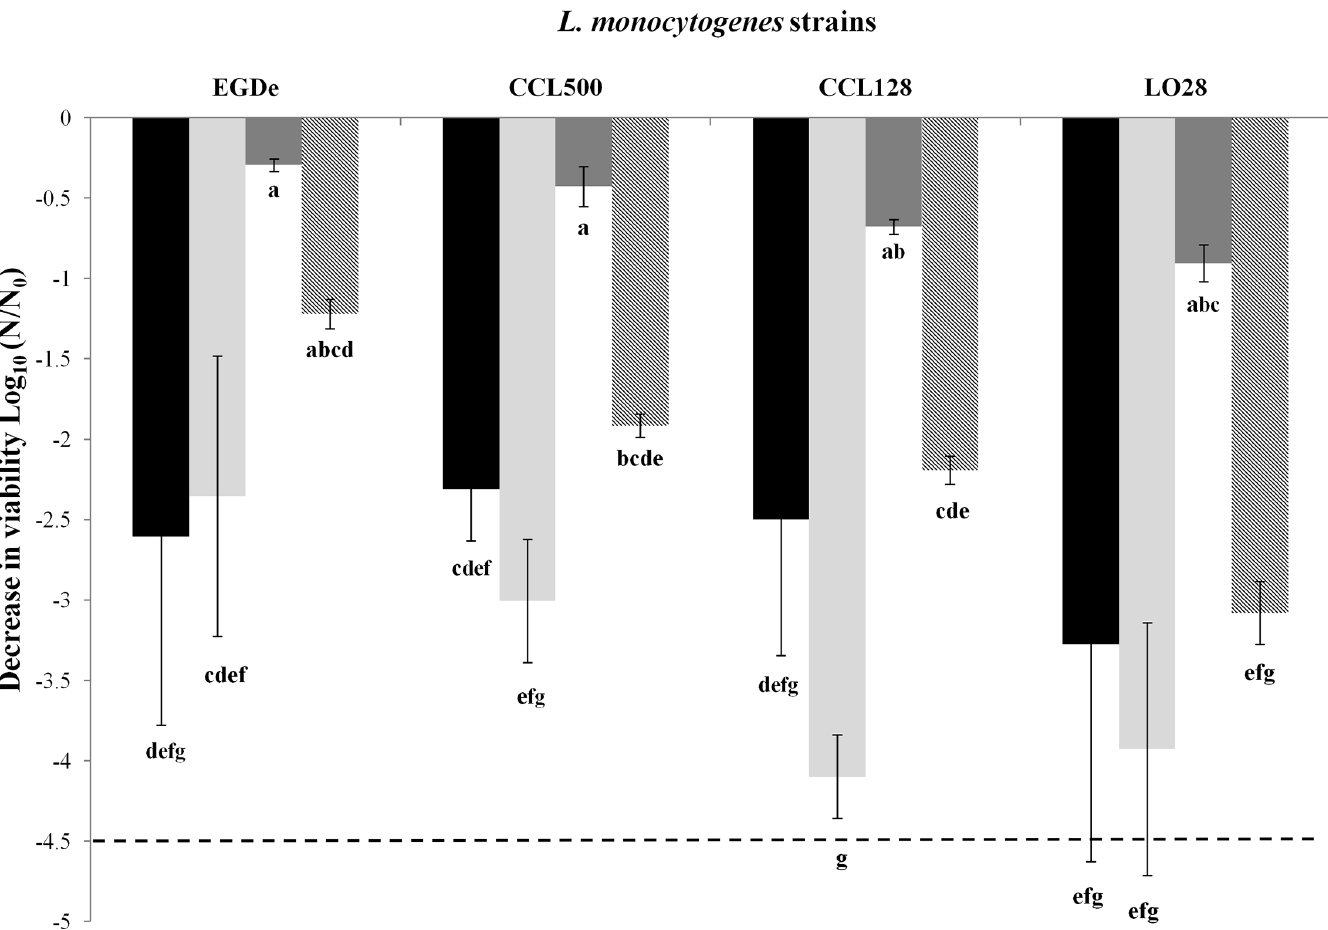
Fig 2. L . monocytogenes survival after different kinetics of rehydration. Decrease in viability of L . monocytogenes strains (EGDe, CCL500, CCL128, and LO28 strains) in PBS during desiccation on polypropylene coupons incubated at 25°C and at 43% RH or 68% RH for 180 min. Initial concentration was equivalent to 10 9 CFU/mL. Two models of rehydration were studied: an instantaneous rehydration and a progressive rehydration. Black bars correspond to drying at 68% RH with a slow rehydration and light gray bars correspond to drying at 68% RH with a rapid rehydration. Dark gray bars correspond to drying at 43% RH with a slow rehydration and hatched bars correspond to drying at 43% RH with a rapid rehydration. Error bars correspond to the SD calculated from four repeated experiments. (- - -) corresponds to the method detection limit.